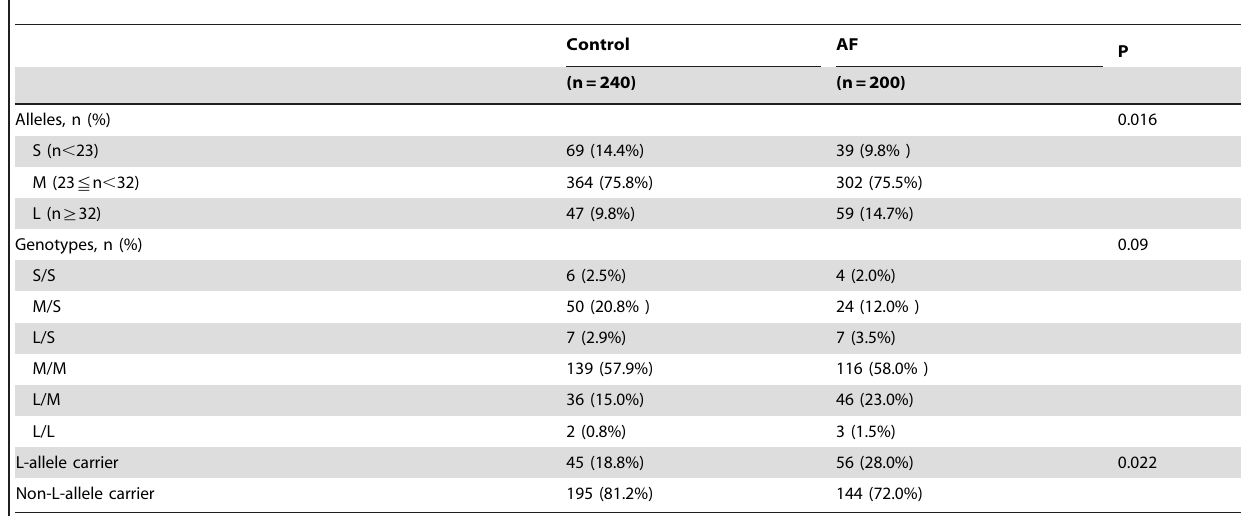
Table 2. Genotype distribution and allele frequencies of HO-1 promoter in the study